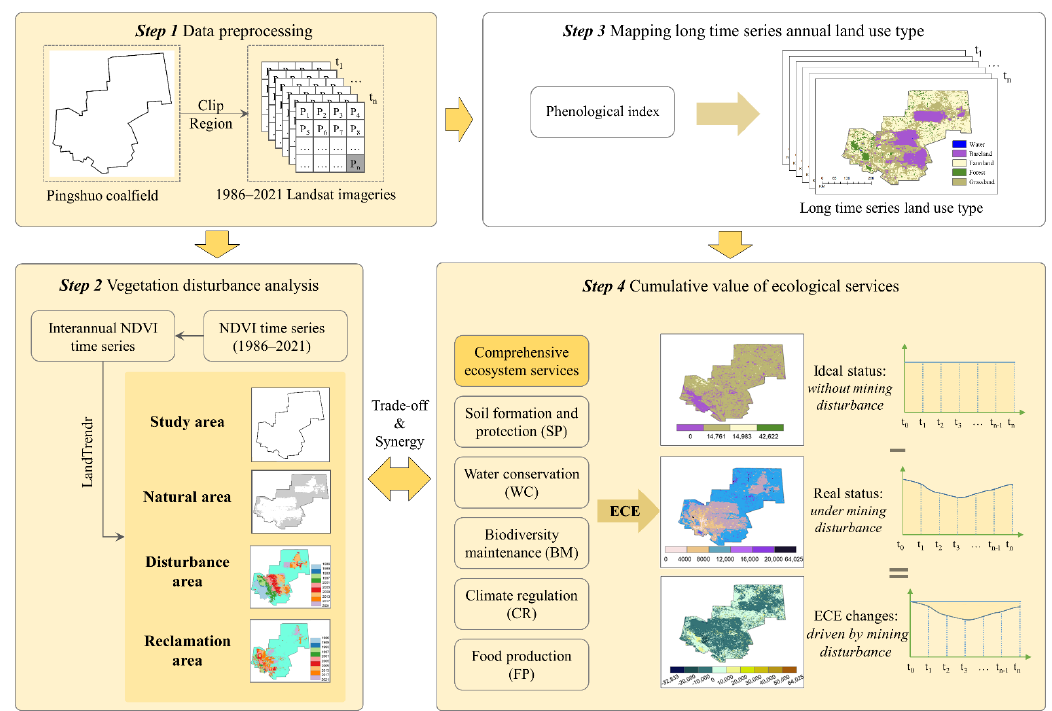
Figure 2. Workflow of data